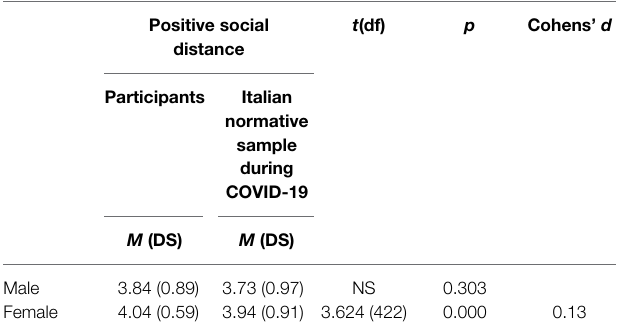
TABLE 8 | Negative attitudes toward social distance: comparison between the average values of the participants and the average values of the Italian normative sample (An et al.,